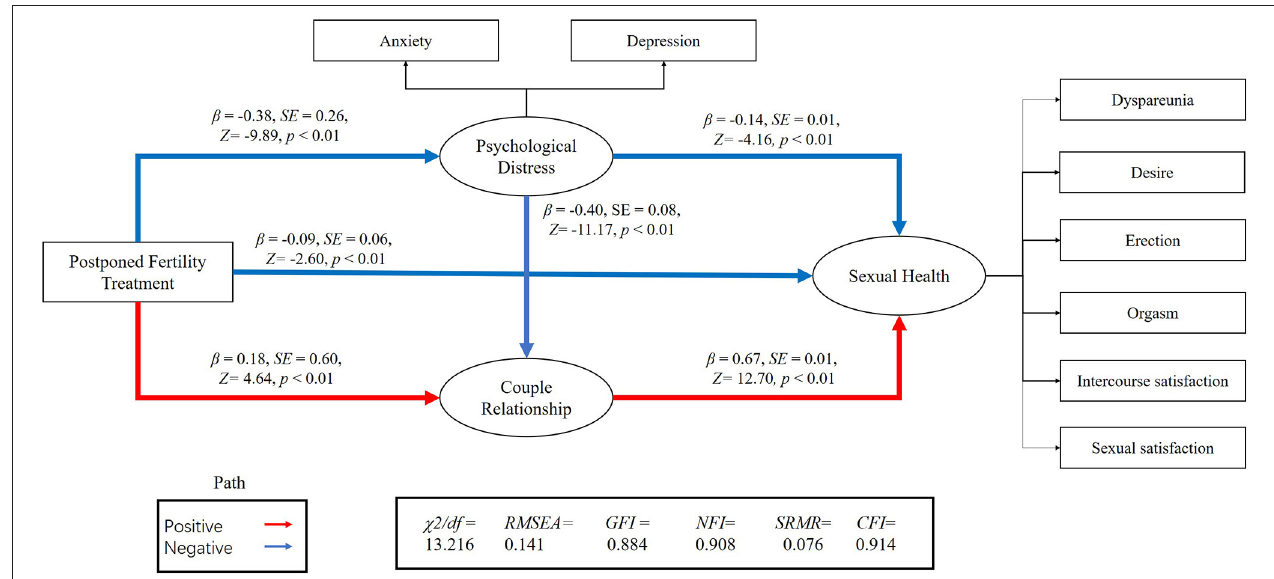
FIGURE 2 | Association between postponed fertility treatment and sexual health mediated by psychological distress and couple relationship quality in